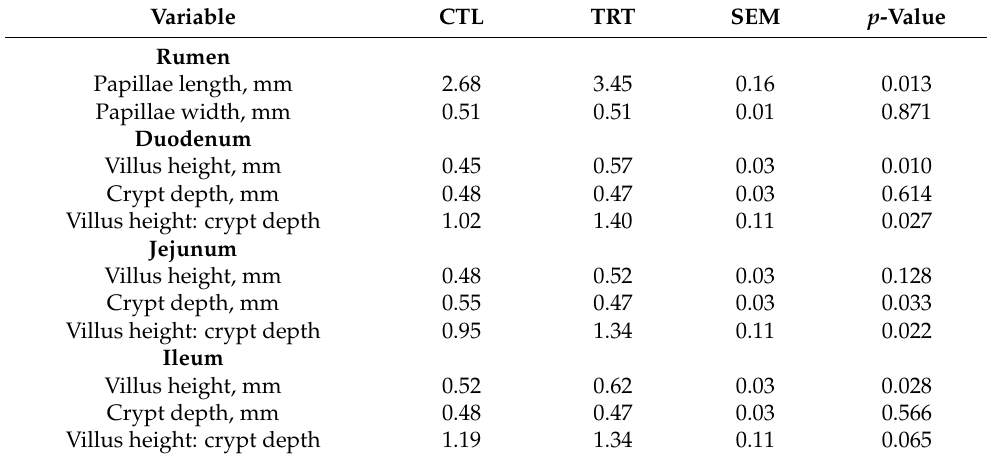
Table 2. The least-square means and associated standard error of the mean (SEM) for parameters representing gastrointestinal morphology in control (CTL) and MCE-fed calves (TRT).